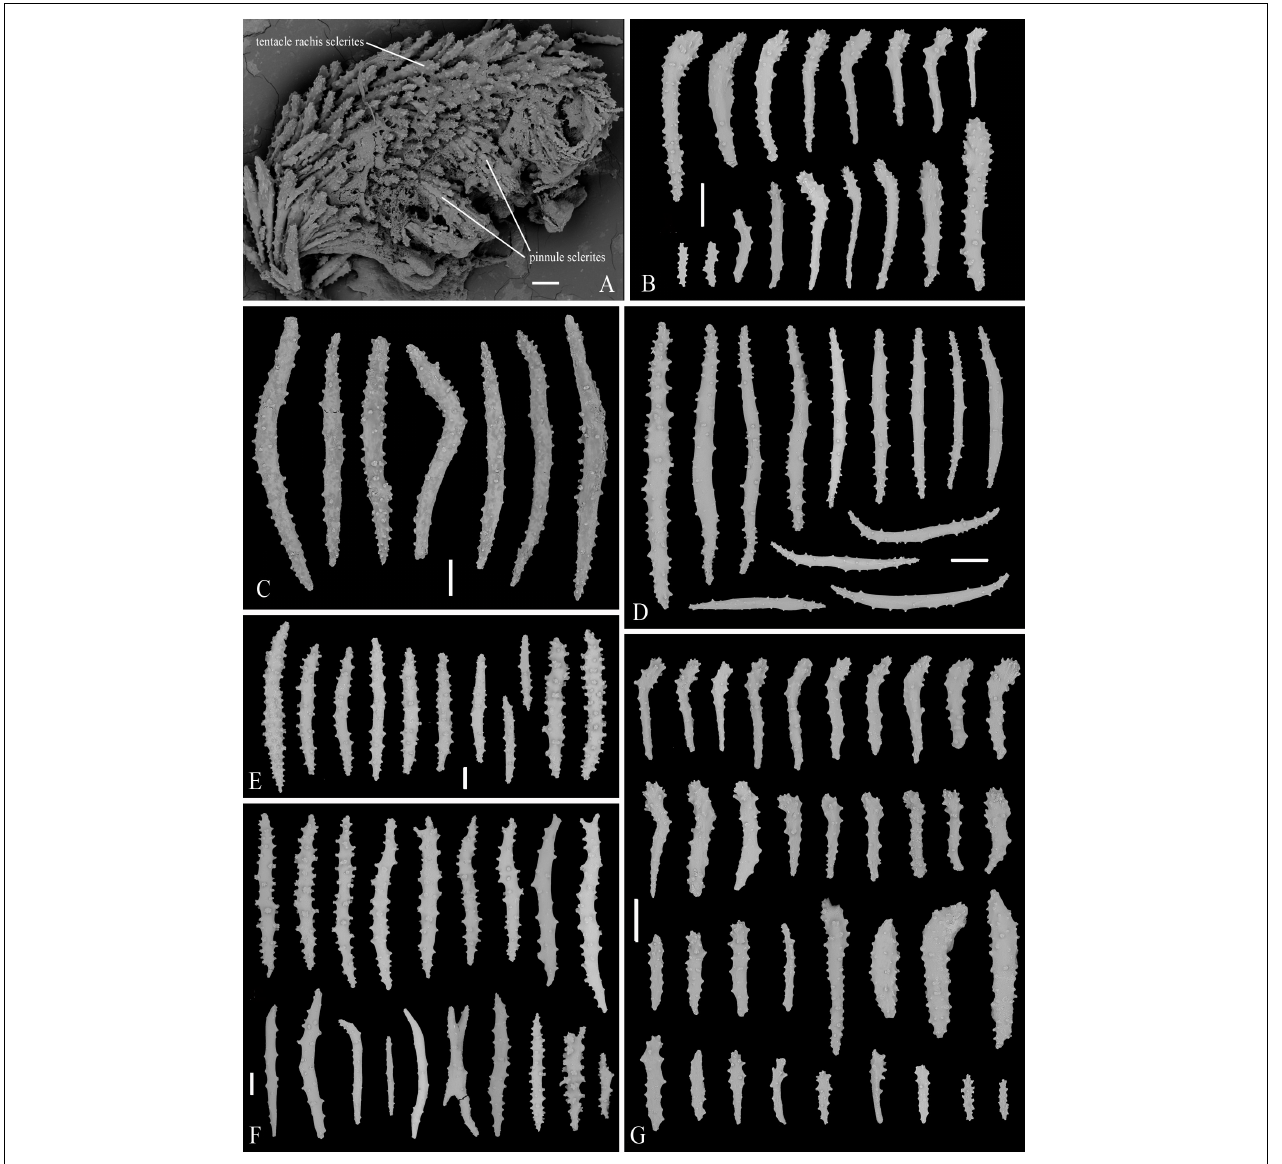
FIGURE 4 | SEM of tentacle and sclerites of Victorgorgia fasciculata sp. nov. (A) Part of tentacle, showing arrangement of sclerites. (B) Sclerites from tentacles of the holotype. (C) Sclerites from point and collaret. (D) Sclerites from calyces of the holotype. (E) Sclerites from cortex of the holotype. (F) Sclerites from medulla of the holotype. (G) Sclerites from tentacles of the paratype. Scale bars = 100 µ m.